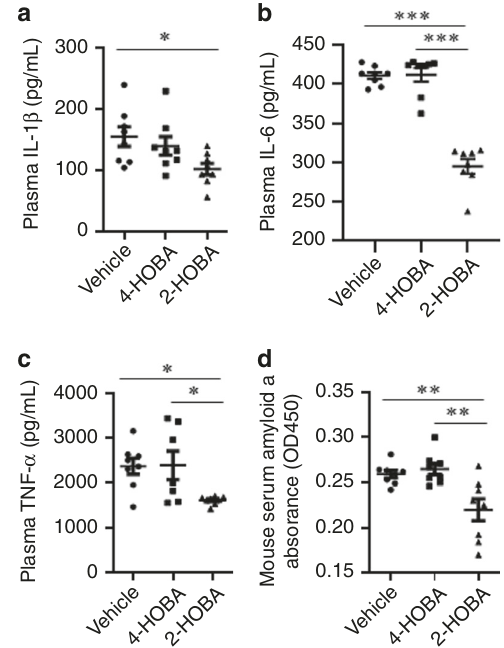
Fig. 5 2-HOBA reduces plasma in fl ammatory cytokines in hypercholesterolemic Ldlr − / − mice. a – d In fl ammatory cytokines were measured in plasma from mice consuming a western diet for 16 weeks and treated with 2-HOBA, 4-HOBA, or vehicle. a IL-1 β levels were measured by ELISA. n = 8 biologically independent mice per group. Data are presented as mean ± SEM. One-way ANOVA with Bonferroni ’ s post hoc test, p value of 2-HOBA vs vehicle is *0.0401 and 2-HOBA vs 4-HOBA is not signi fi cant. b IL-6 levels were measured by ELISA. n = 8 biologically independent mice per group. Data are presented as mean ± SEM. One-way ANOVA with Bonferroni ’ s post hoc test, p values of 2-HOBA vs 4-HOBA and 2-HOBA vs vehicle are ***<0.0001. c TNF- α levels were measured by ELISA. n = 8 (vehicle), 7 (4-HOBA), or 8 (2-HOBA) biologically independent mice. Data are presented as mean ± SEM. One-way ANOVA with Bonferroni ’ s post hoc test, p values of 2-HOBA vs 4-HOBA and 2-HOBA vs vehicle are *0.0385 and *0.0359. d The levels of SAA were measured by ELISA. n = 8 biologically independent mice per group. Data are presented as mean ± SEM. One-way ANOVA with Bonferroni ’ s post hoc test, p values of 2- HOBA vs 4-HOBA and 2-HOBA vs vehicle are **0.0025 and **0.0082. Source data are provided as a source data fi